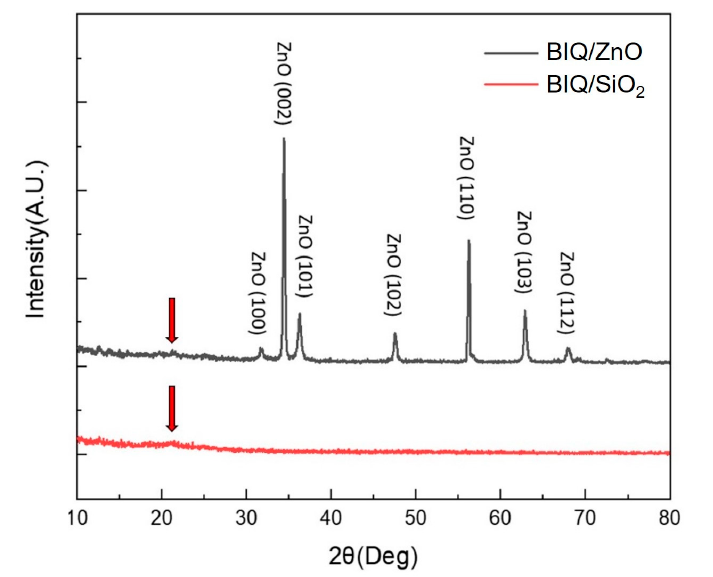
Figure 3. The XRD profile of BIQ deposited on the SiO 2 substrate and the ZnO NRs. The red arrows indicate the characteristic XRD peak of BIQ.